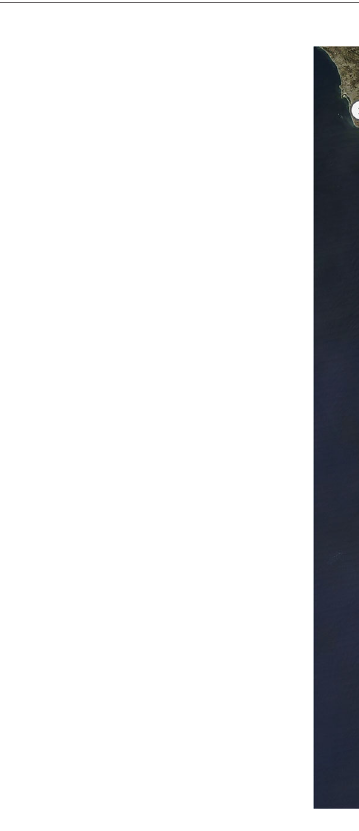
FIGURE 2 | Map of Baja California, where each circle represents a fi shery of fi ce recorded in the CONAPESCA database, and each square demarcates the approximate spatial footprint of fi shing trips for which there exist records of fuel consumption in the GCMP (Gulf of California Marine Program) database. For a complete roster of CONAPESCA of fi ce names, see Table S1 . Respectively, the of fi ces shown in green (#5 - #10), blue (#11 - #13), purple (#15), and red (#25 - #31), represent those with fi shery reports that we used to generate stock assessment pro fi les for “ Stocks of Interest ” in the “ Central Paci fi c ” , “ Lower Paci fi c ” , “ Lower Gulf ” , and “ Upper Gulf ” (as described in Section 2.4). Conversely, we did not utilize CONAPESCA landings data reported by those of fi ces shown in grey. (Underlying map of Baja California is courtesy of the MODIS Rapid Response Team and NASA, and is available for download at: